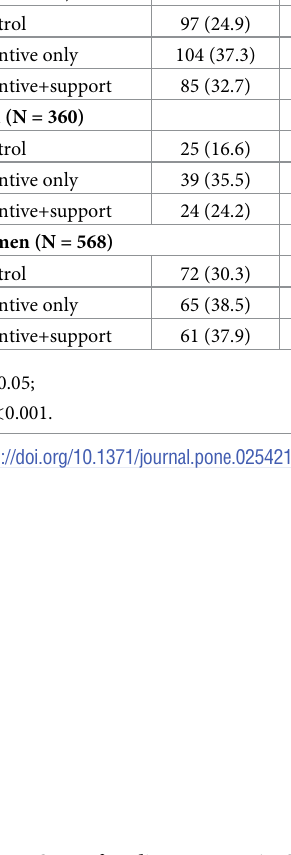
Table 3. Stage of readiness to use PARC at 12